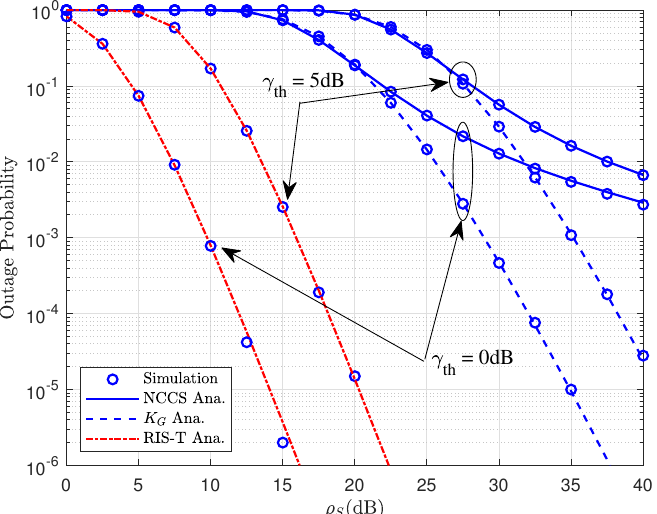
Figure 6. The outage probability vs. ρ S (dB) with varying γ th .